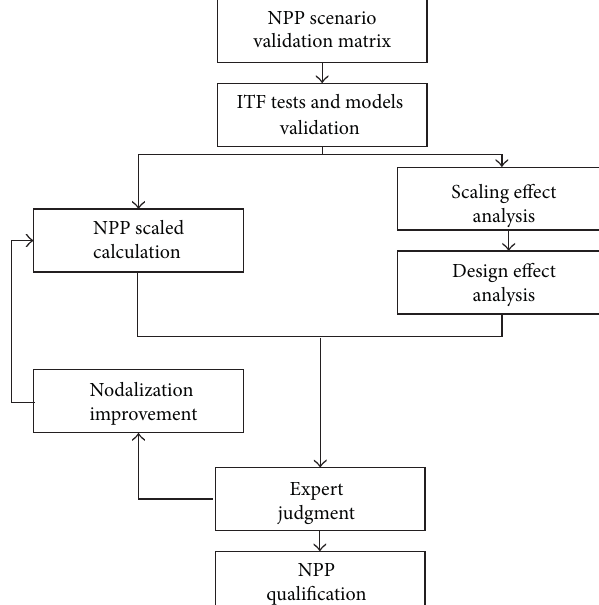
(b) the differences of configuration between the ITF and Figure 4: UPC scaling-up